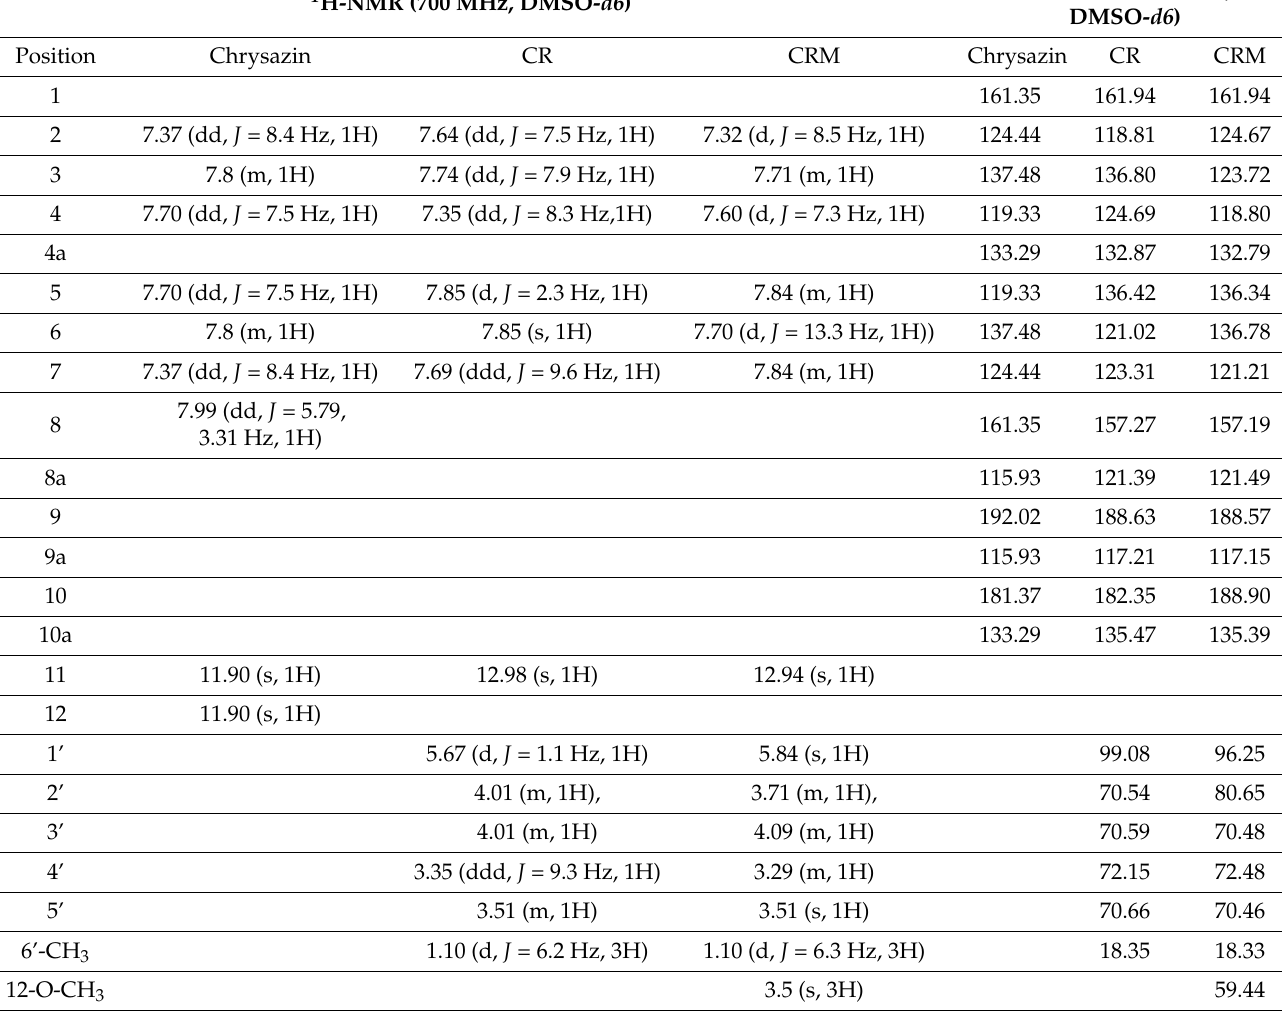
Table 1. Comparison of 1 H- and 13 C-NMR chemical shifts of chrysazin, chrysazin-8-O- α - L - rhamnoside (CR), and chrysazin-8-O- α - L -2 (cid:48) -O-methylrhamnoside (CRM) measured in